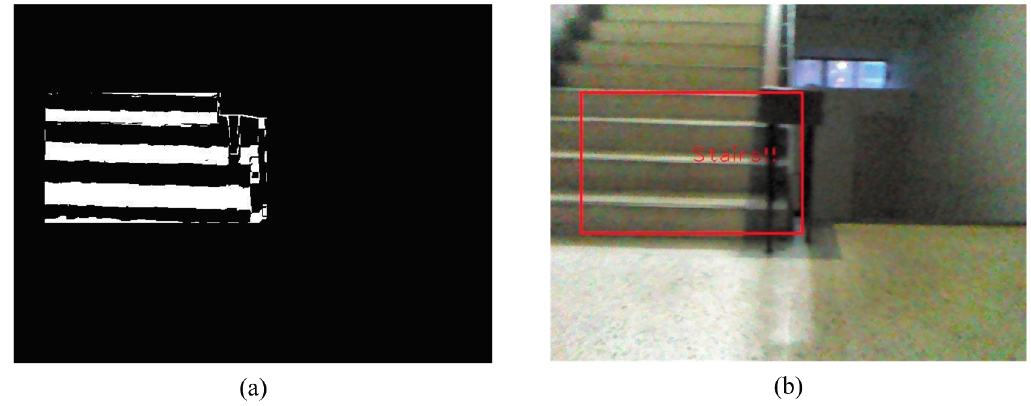
Figure 18. The detection of rising stairs. ( a ) Satisfied conditions of a suspicious plane; ( b ) Upstairs detection image.